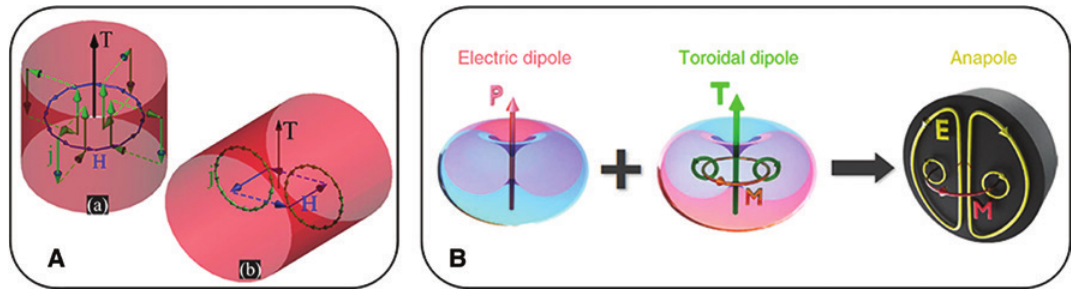
Figure 8: The combination of a magnetic toroidal dipole moment and an electric dipole moment in a dielectric (A) nanorod [141] and (B) nanodisc can create an anapole moment [111]. Figure reproduced from (A) Ref. [141], OSA; (B) Ref. [111], Creative Commons CC-BY